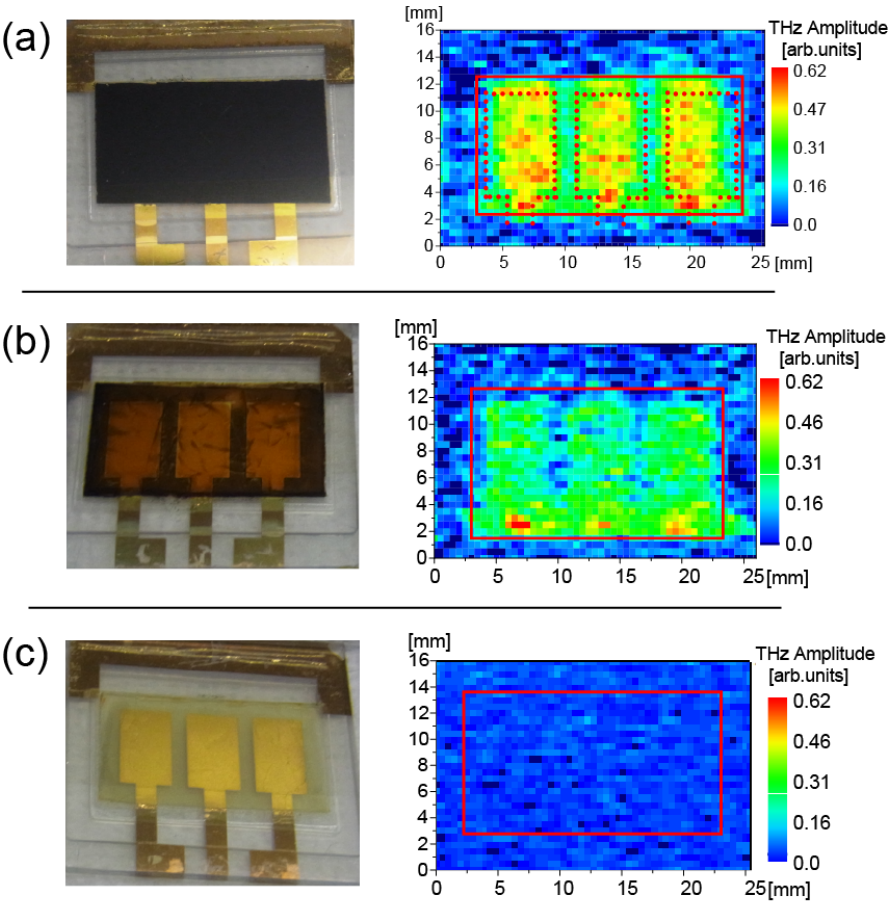
Figure 5. Pictures and LTEM images of the perovskite solar cell modules with various degradation conditions. The best energy conversion efficiencies of three cells in each modules were ( a ) 9.98%, ( b ) 0.63%, and ( c ) 0%. The solid and dotted red squares show the position of the cells and gold electrodes,